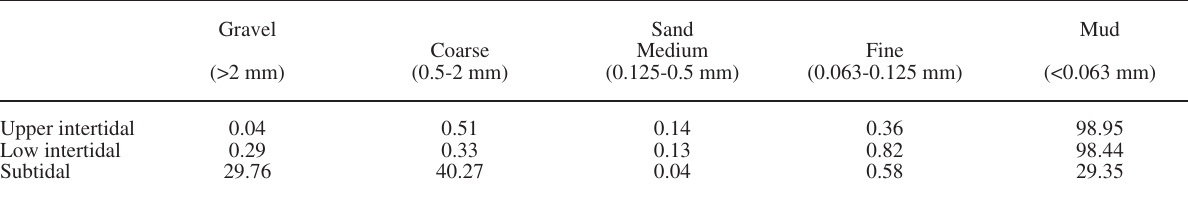
Table 1. – Sediment grain size of the three sampled areas